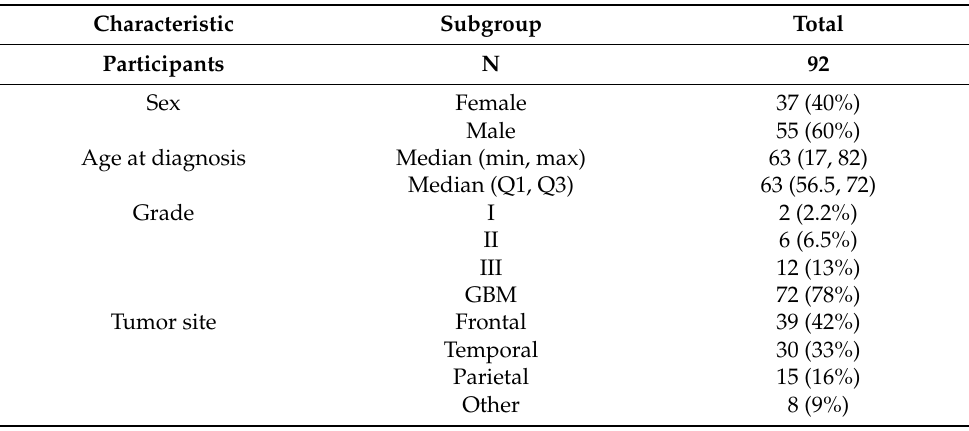
Table 3. Demographics and clinical characteristics of patient